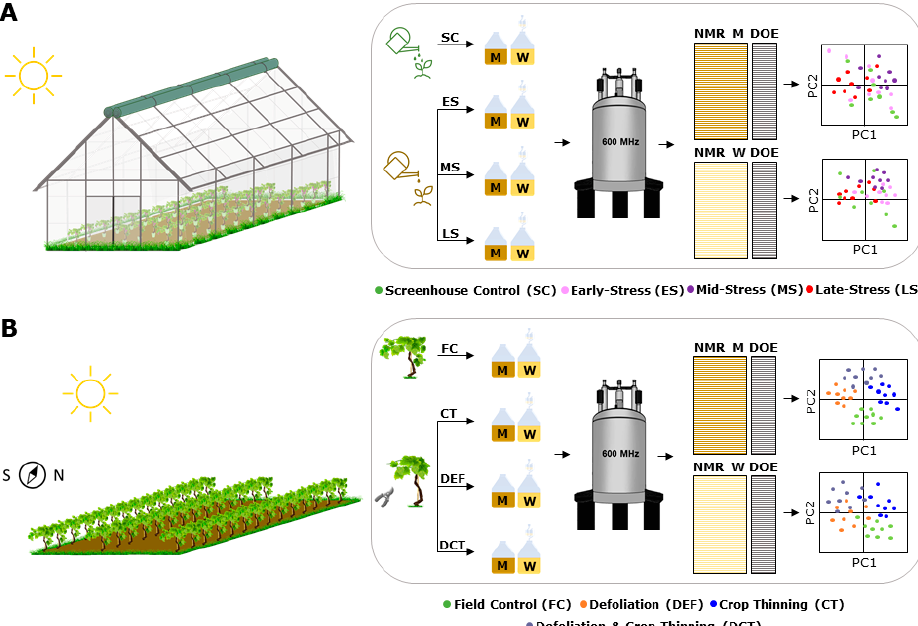
Figure 1. Experimental design. The water deficit experiment was carried out in an “open” screen- house set up ( A ) where 36 pot-grown vines underwent water stress at three different phenological stages of berry development, namely pre-veraison (early-stress, ES), veraison (mid-stress, MS), and ripening (late-stress, LS). The field experiment ( B ) was performed in a north–south oriented vineyard where 32 vines underwent different viticultural treatments, namely crop thinning (CT), defoliation (DEF), and a combination of the above (DCT). Must and wine samples from all treatments were stored at − 80 °C until 1 H NMR measurements. Multivariate analysis was employed to assess the impact of different growing conditions (field vs. screenhouse), water deficit, and viticultural practices on the chemical composition of must and wine samples. M: must; W: wine; DOE: design of experiment. Color-coding for the PCA scores is given in the figure legend.